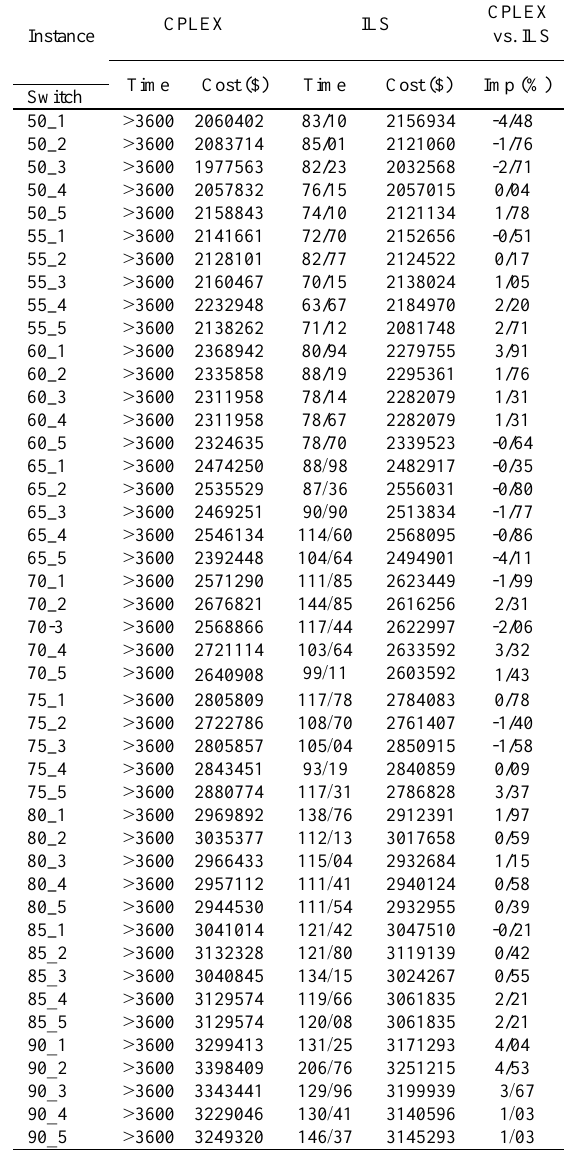
Table 2. Results obtained from ILS algorithm and CPLEX on instances of medium size.